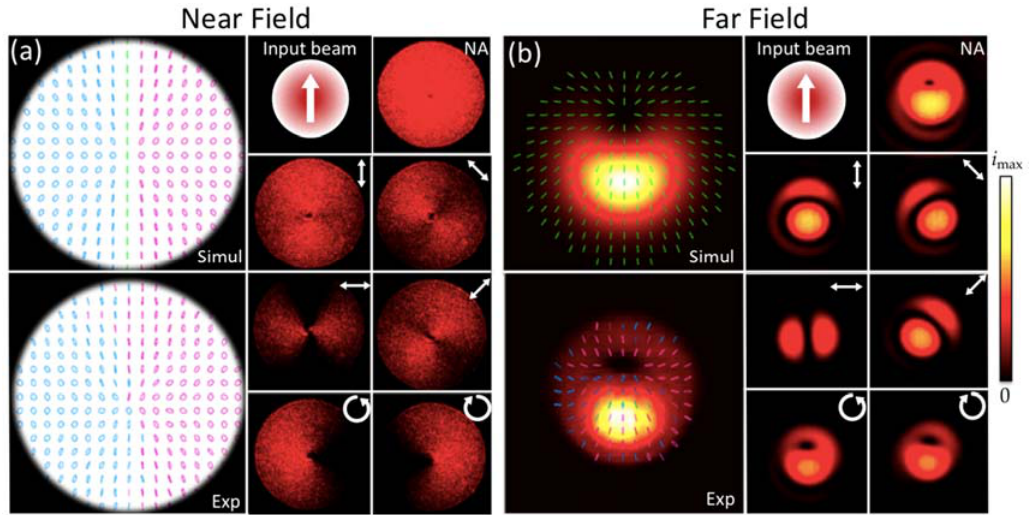
Figure 5. Results for a QW q ‐ plate illuminated with linear vertical polarization and ℓ = 0. ( a ) Results in the near field; ( b ) results in the far field. Simulated and experimental polarization maps, with equivalent color representation as in Figure 3. Experimental images captured for different orientations of the analyzer, indicated as white arrows (NA indicates no analyzer).